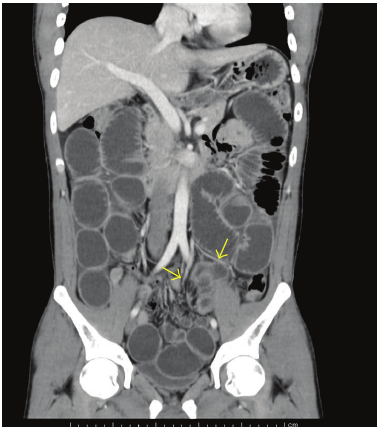
Figure 1: Computed tomography: abdominal computed tomogra- phy revealed an extensively dilated small bowel and a closed loop of small bowel in the mesosigmoid. The arrows indicate vessels of the mesosigmoid.